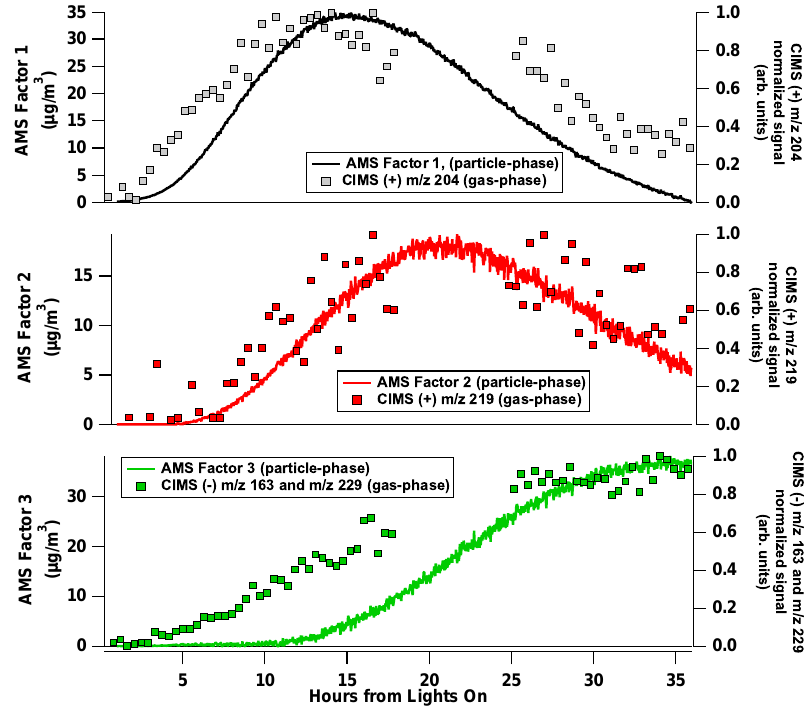
Fig. 10. Particle-phase HR-ToF-AMS factor time series with gas-phase CIMS time